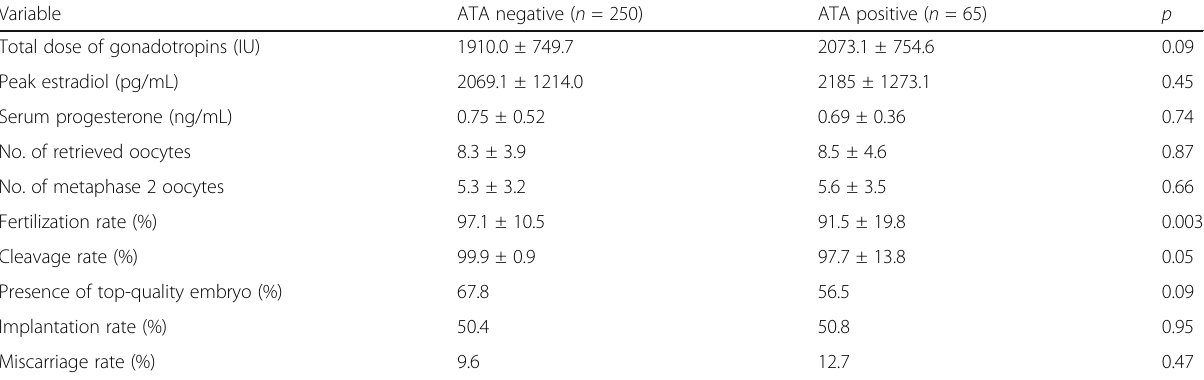
Table 2 Cycle outcomes of ATA-negative and ATA-positive patients Variable